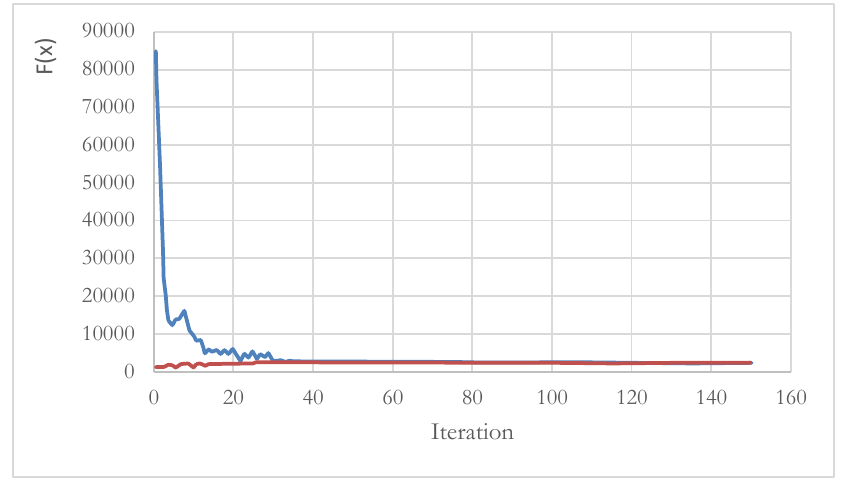
Fig. 2. Upper and lower bound convergence of the Lagrange release algorithm with the release of three constraints.